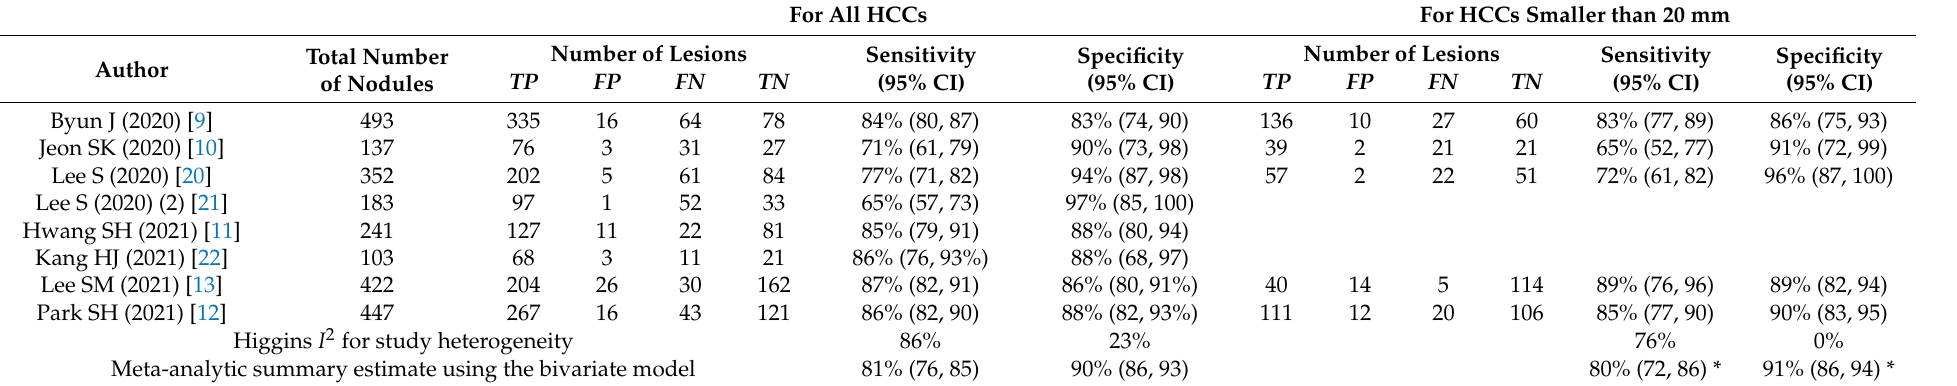
Meta-analytic summary estimate using the bivariate